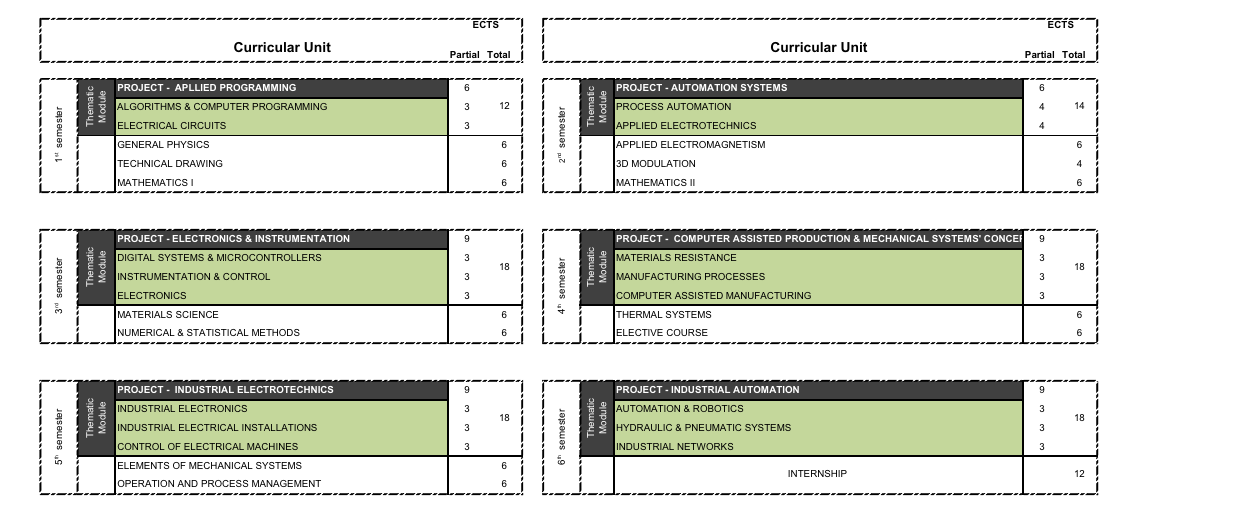
TABLE 1 Industrial Electronics and Mechanics curricular